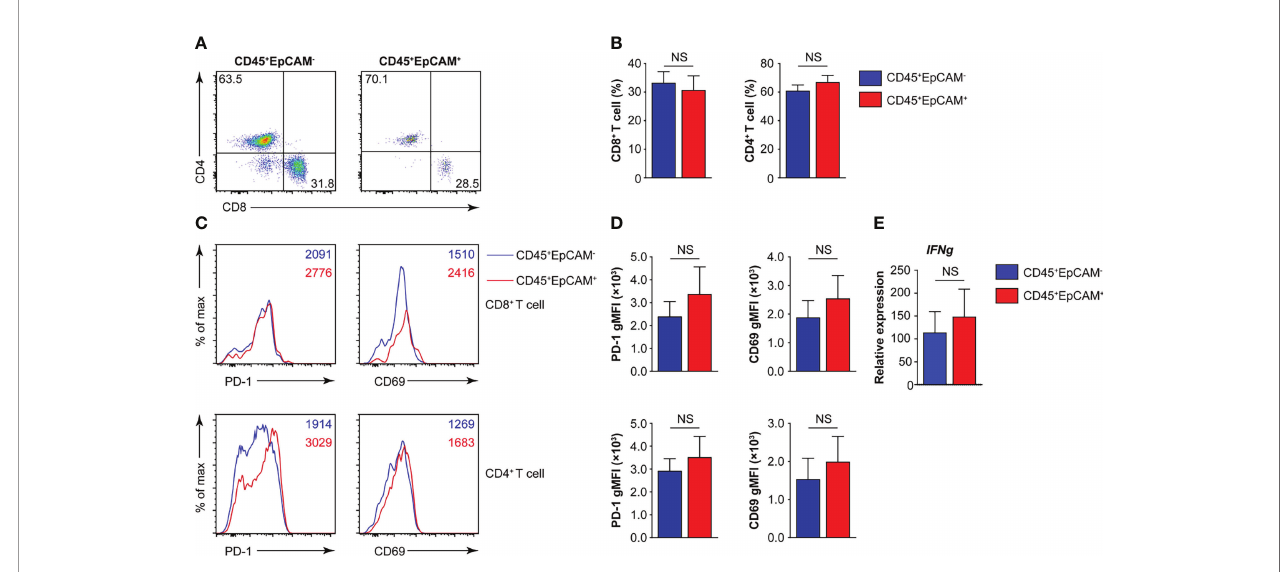
FIGURE 2 | CD45 + EpCAM + CD8 + T cells in lung cancer express PD-1 andCD69. (A, B) Flow cytometry analysisof CD8 + T andCD4 + T cellsgated onCD45 + EpCAM + CD3 + and CD45 + EpCAM − CD3 + cells from tumors of patients with lung cancer with representative pseudocolor plot and cumulative data in (A) and (B) , respectively ( n= 8). (C, D) Expressionof PD-1 and CD69 on CD8 + T and CD4 + T cells was analyzed using fl ow cytometrywith typical histograms and quanti fi cationdata in (C) and (D) , respectively ( n ≥ 8). (E) Quantitative RT-PCR analysis of IFNg from sortedCD45 + EpCAM + and CD45 + EpCAM − cells after PBMCs cultured with HCC827 cellconditioned media ( n ≥ 4) NS, no signi fi